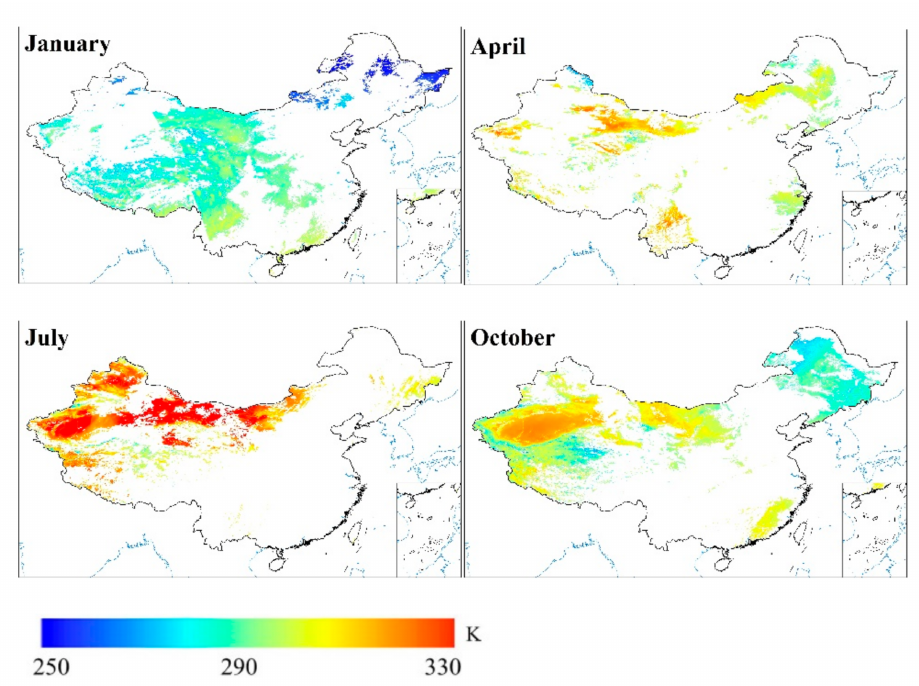
Figure 4. Spatial distributions of MODIS LST during daytime of the 17th, 107th, 196th, and 291st days of the year 2010, representing different months.